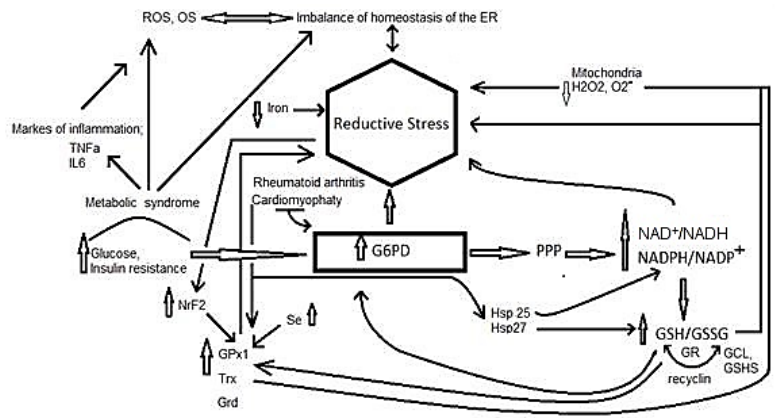
Figure 2. Participation of several agents such as the reducing equivalents, antioxidant enzymes and pathologies in reductive stress. Abbreviations: G6PD = glucose 6 phosphate dehydrogenase, NAD = nicotinamide adenine dinucleotide, NAD + = nicotinamide adenine dinucleotide oxidized, NADH = nicotinamide adenine dinucleotide reduced, NADPH = nicotinamide adenine dinucleotide phosphate reduced, GSH = glutathione, GSSG = glutathione disulfide, PPP = pentose phosphate pathway, γ -glutamyl-cysteine synthase, GSHS = glutathione synthetase, GPx = Glutathione peroxidase, Trx = thioredoxin, Grd = glutaredoxin, TNFα = tumor necrosis factor alpha, NrF2 = erythroid related factor 2, IL6 = interleukin 6, ROS = reactive oxidative species, OS = oxidative stress, ER = endoplasmic reticulum, Se = selenium, Hsp = heat shock protein, GR = glutathione reductase. 4.1. Nicotinamide Adenine Dinucleotide oxidized/Nicotinamide Adenine Dinucleotide reduced Ratio